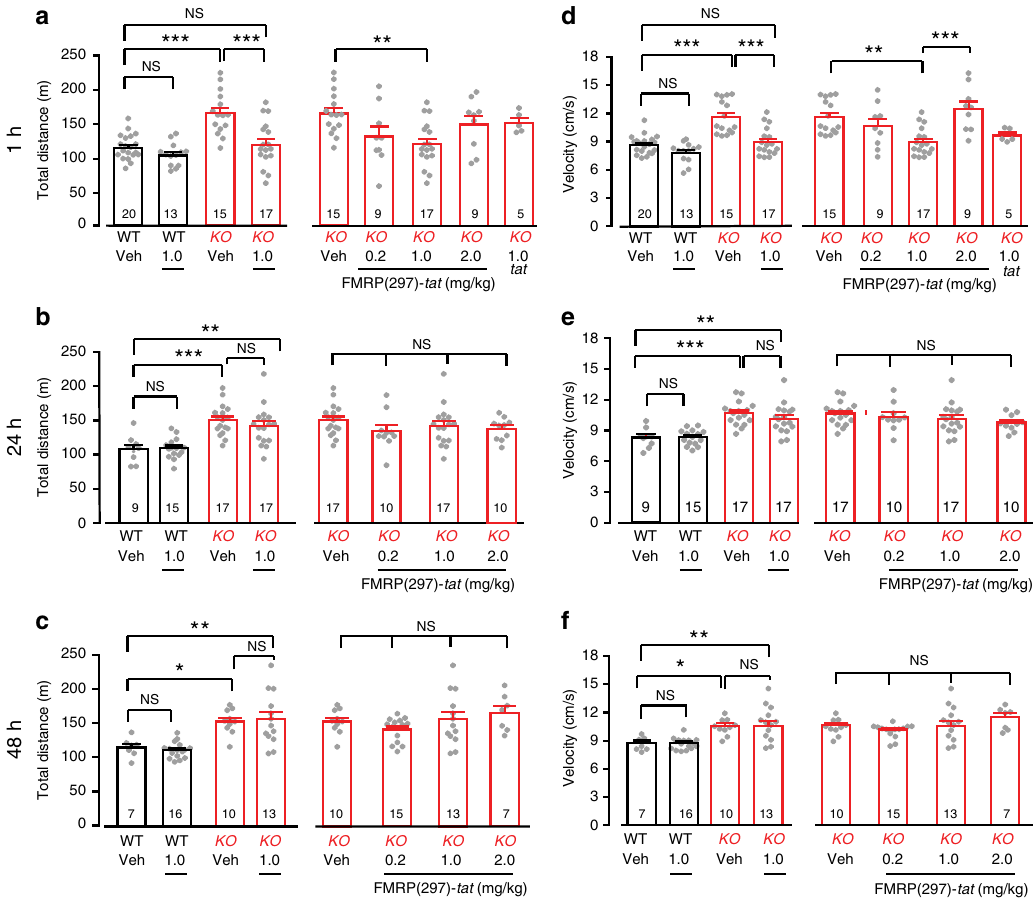
Fig. 8 FMRP(1 – 297)- tat reduces elevated levels of activity in Fmr1 KO mice. Shown are mean bar-dot plots for total distance ( a – c ) and mean velocity ( d – f ) in P55 – 100 WT and Fmr1 KO mice over 30 min in an open fi eld test (OFT) at 1, 24, and 48 h following tail vein injection of vehicle, different concentrations of FMRP(1 – 297)- tat , or tat epitope alone. Fmr1 KO mice exhibit higher levels of activity compared to WT animals in terms of total distance traveled in the fi eld that is signi fi cantly reduced at 1 h by 1.0 mg/kg FMRP (1-297)- tat tail vein injection ( a left panel: two-way ANOVA analysis of the interaction between genotype and treatment F (1,61),interaction = 6.792, p = 0.012; post hoc Tukey ’ s test: p (KO veh,WT veh) < 0.0001, p (KO veh,KO 1.0) < 0.0001; a right panel: one-way ANOVA F (4,54) = 3.817, p = 0.00875; post-hoc Tukey ’ s test: p (KO veh,KO 1.0) = 0.00475), as well as the velocity of movement ( d , left panel: Two-way ANOVA F (1,61),interaction = 7.035, p = 0.0102; post hoc Tukey ’ s test: p (KO veh,WT veh) < 0.0001, p (KO veh,KO 1.0) < 0.0001; d right panel: one- way ANOVA F (4,54) = 6.943, p = 1.6 × 10 − 4 ; post hoc Tukey ’ s test: p (KO veh,KO 1.0) = 0.00187). By comparison the level of activity in Fmr1 KO mice is not affected by 1.0 mg/kg tat epitope alone ( a right panel: post hoc Tukey ’ s test p (KO veh,KO tat) = 0.937; d right panel: post hoc Tukey ’ s test p (KO veh,KO tat) = 0.268). Similarly, injection of 1.0 mg/kg FMRP(1 – 297)- tat in WT animals had no signi fi cant effect on distance or velocity for any of the 1, 24, or 48 h time points (left panels for distance: a post hoc Tukey ’ s test: p (WT veh,WT 1.0) = 0.629; b p (WT veh,WT 1.0) = 0.999; c p (WT veh,WT 1.0) = 0.636; left panels for velocity: d p (WT veh,WT 1.0) = 0.324; e p (WT veh,WT 1.0) = 0.9998; f p (WT veh,WT 1.0) > 0.9999). Animals used for behavioral tests ranged from P55 – P100. Average values are mean ± s.e.m, and sample values identi fi ed at the base of bar plots represent the number of animals. * p < 0.05, ** p < 0.01, *** p < 0.001, NS not signi fi cant. Source data are provided as a Source Data fi